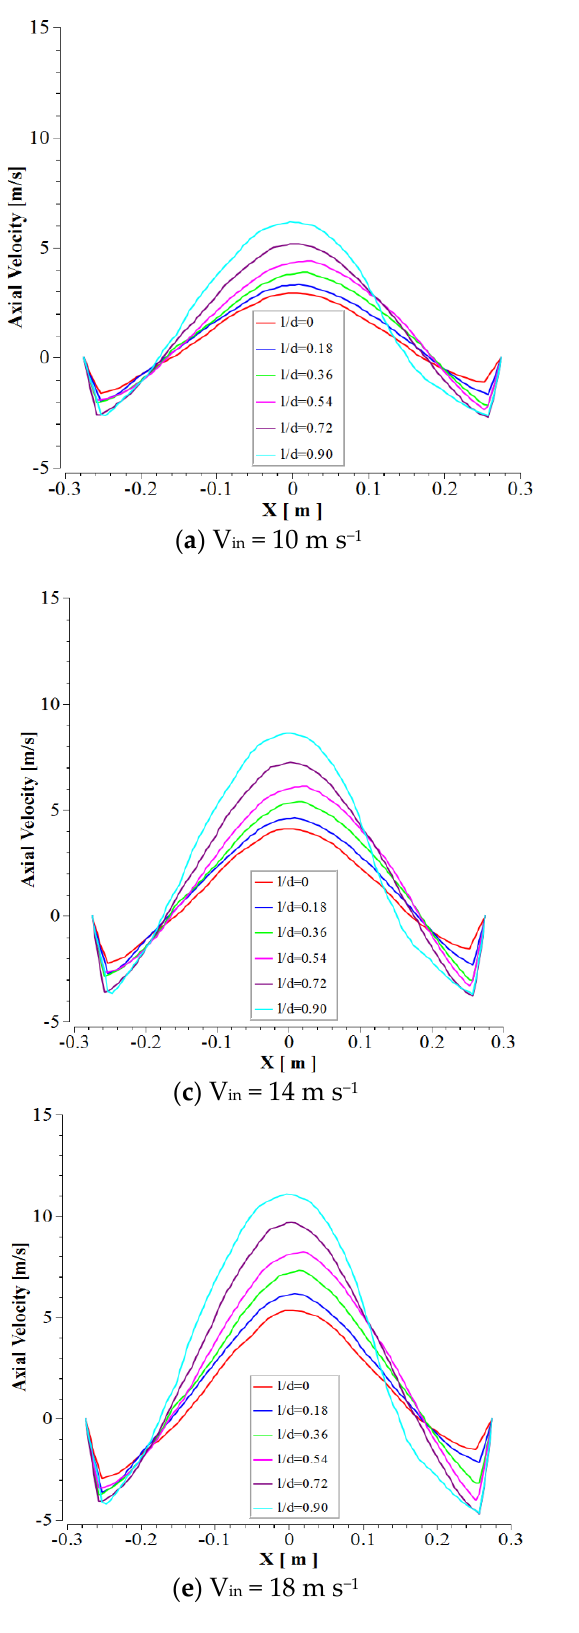
Figure 7. The variation of axial velocity graphs of 6 various cyclone cylinder heights in various inlet velocities. Figure 7.